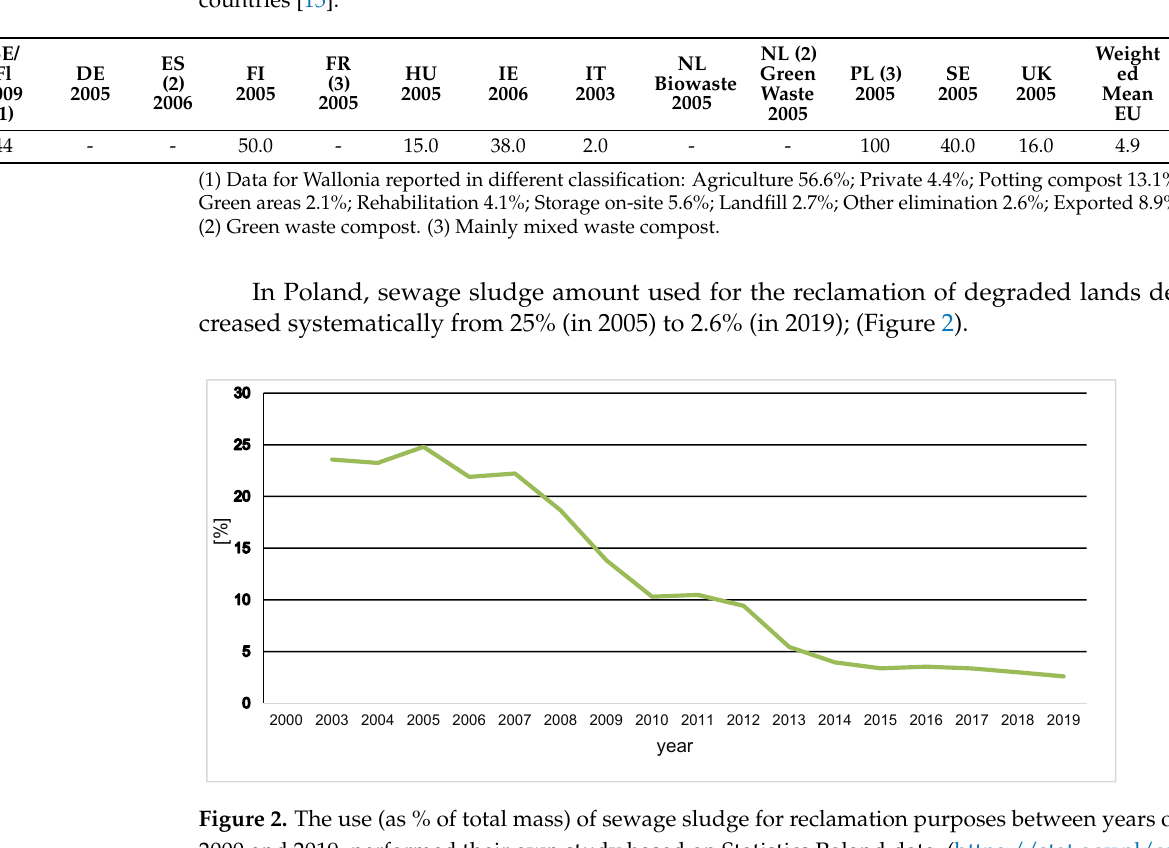
Figure 2. The use (as % of total mass) of sewage sludge for reclamation purposes between years of 2000 and 2019, performed their own study based on Statistics Poland data, (https://stat.gov.pl/en, accessed on 28 November 2021) [16].